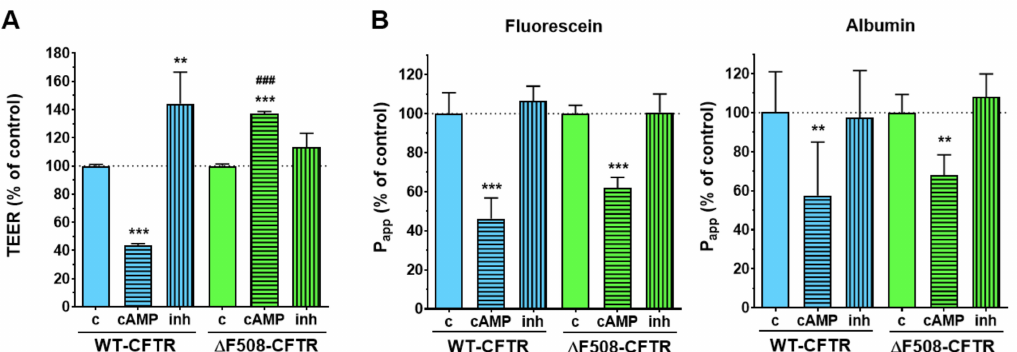
Figure 4. E ff ects of a cell-permeable cAMP analog (250 µ M) and the CFTR channel inhibitor CFTR inh -172 (inh; 10 µ M) treatment (1 h) on the electrical resistance ( A ) and permeability ( B ) values. Values: percentage of control groups. Means ± SD, n = 4 / group. 2-way ANOVA and Bonferroni test. ** p < 0.01, *** p < 0.001 compared to the control groups, ### p < 0.001 compared to the respective wild-type